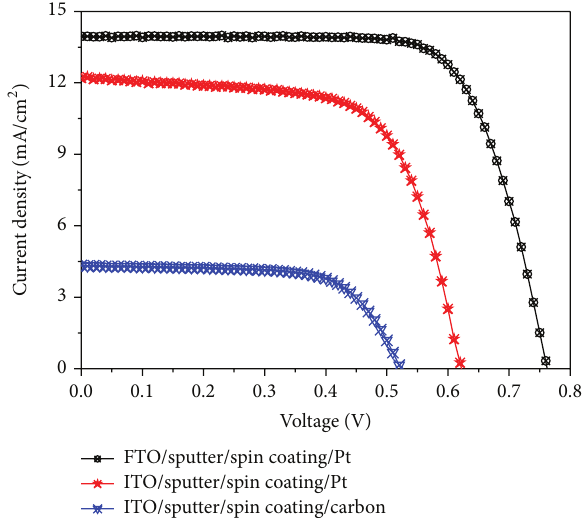
Figure 11: Current-voltage plots for the DSSC with a sputtered compact TiO 2 layer, using carbon and Pt counter electrodes and FTO and ITO/glass, under AM 1.5 solar irradiation with a density of 100 mW/cm 2 (TiO 2 annealed at 450 ∘